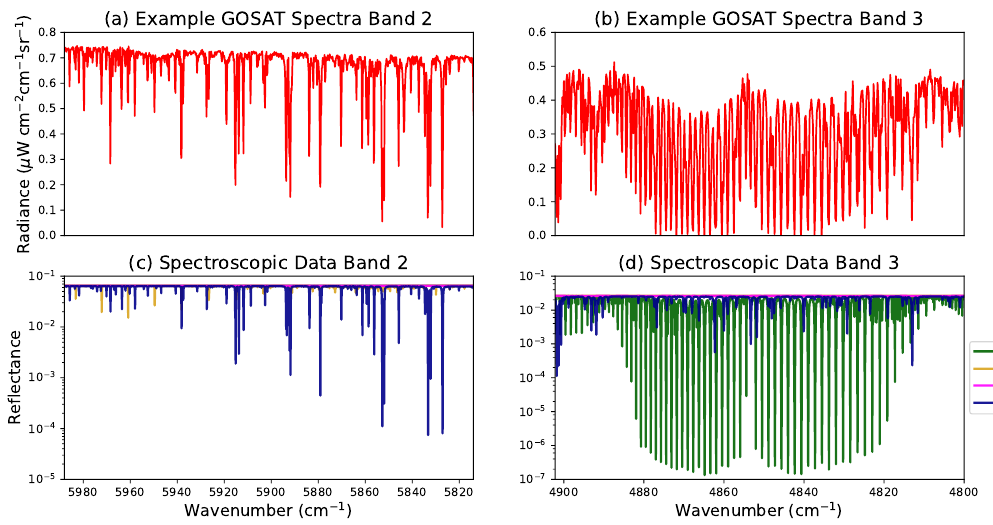
Figure 2. Example GOSAT short wave infrared spectra for bands 2 ( a ) and 3 ( b ). Contribution of main absorbers for bands 2 and 3 are shown in ( c , d ) respectively. Spectral lines of absorbers are shown at the native resolution of the spectrascopic database and have not had the GOSAT instrument line shape